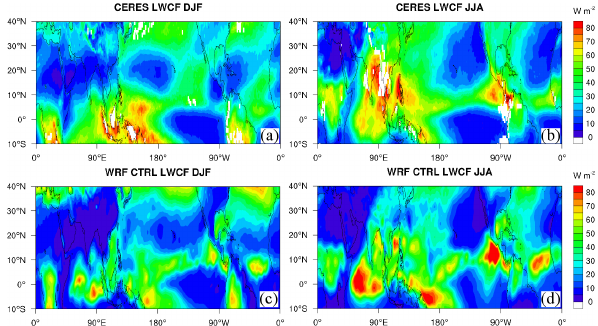
Fig. 2. 4-yr averaged water vapor (ppmv) at 100hPa. (a) MLS in DJF; (b) MLS in JJA; (c) WRF CTRL in DJF; (d) WRF CTRL in JJA.